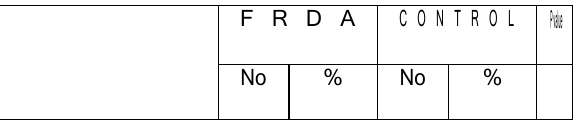
equal or 20 years or more respectively and it was statically significant, (p=0.006),see the table (3-4).The level of vitamin E in friedreichs ataxic phenotypic patients according to the Gender showed that male patients had higher vitamin E level (12.05±2.66) compared to females(10.17±1.07) and it was statically significant(p=0.003),see the table (3-4).The level of vitamin E in relation to the gender in the control